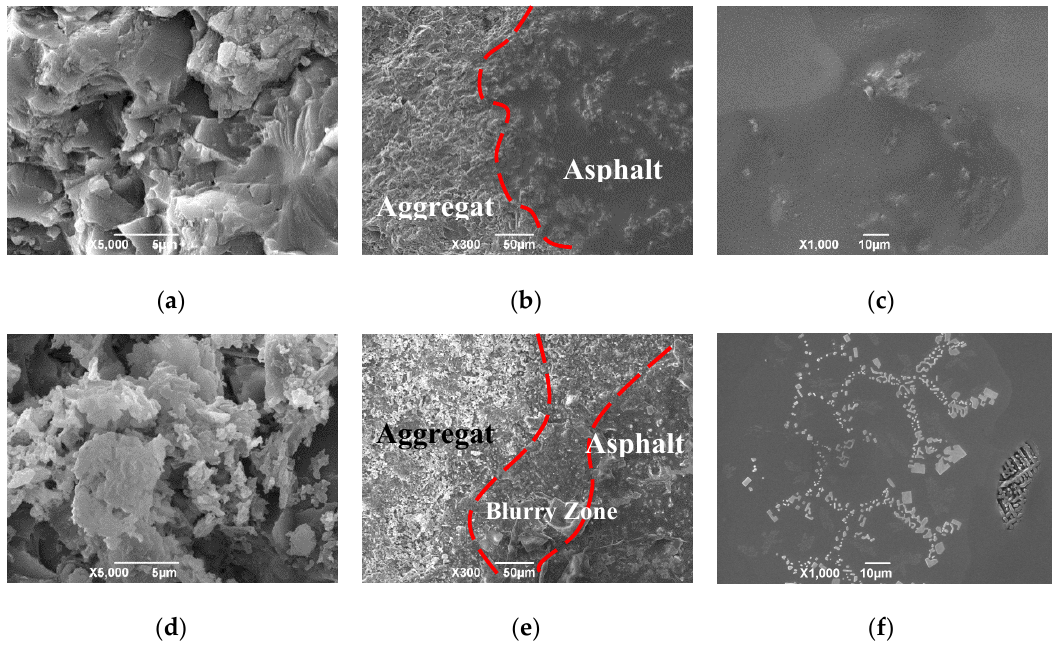
Figure 13. SEM images on aggregate surface, aggregate-asphalt interface, and asphalt surface of ( a – c ) control samples and ( d – f ) treated samples.